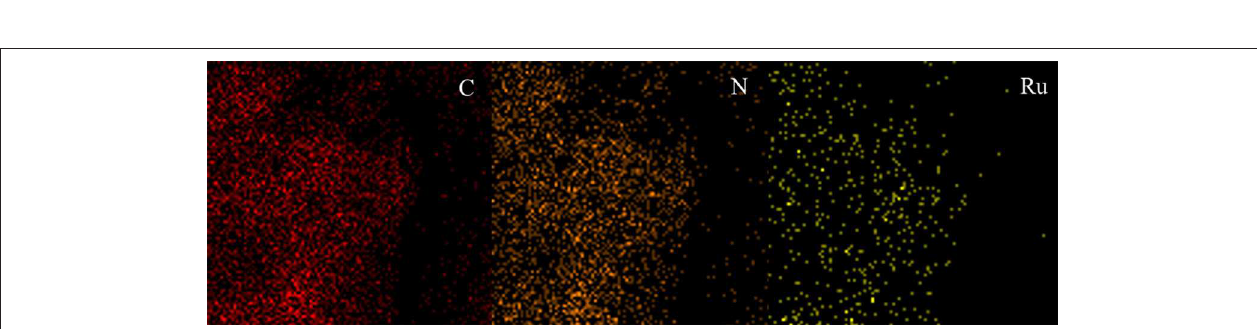
FIGURE 3 | TEM mapping of C, N, and Ru.